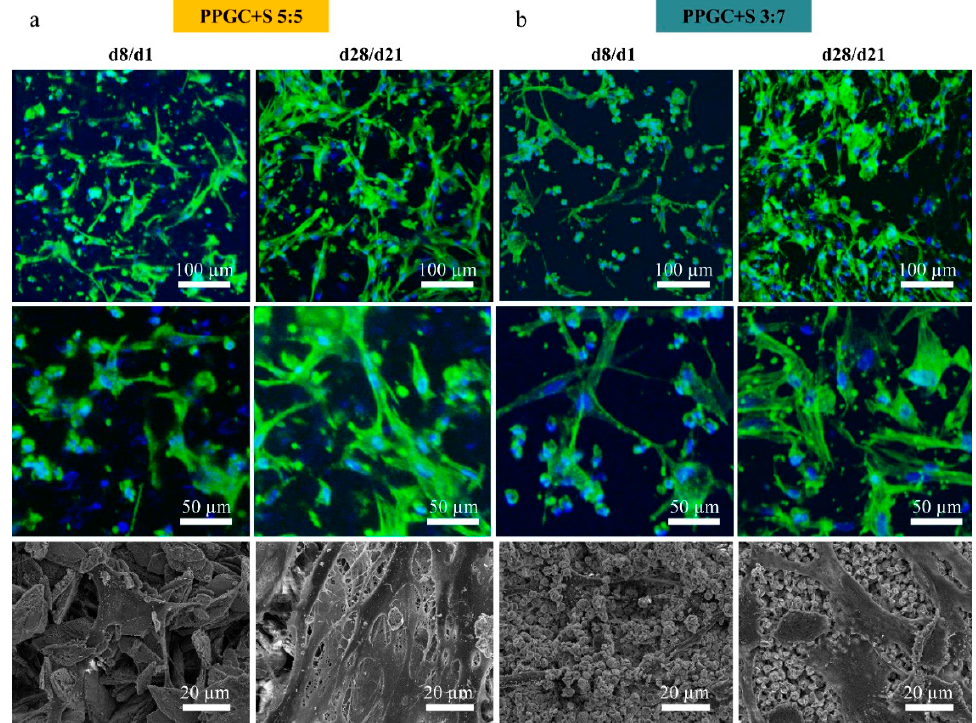
Figure 3. Confocal laser scanning microscope (cLSM) (upper row) and SEM pictures (lower row) of osteoblasts and monocytes / osteoclasts on PPGC + S 5:5 ( a ) and PPGC + S 3:7 ( b ). The actin skeletons (green) and the nuclei (blue) are